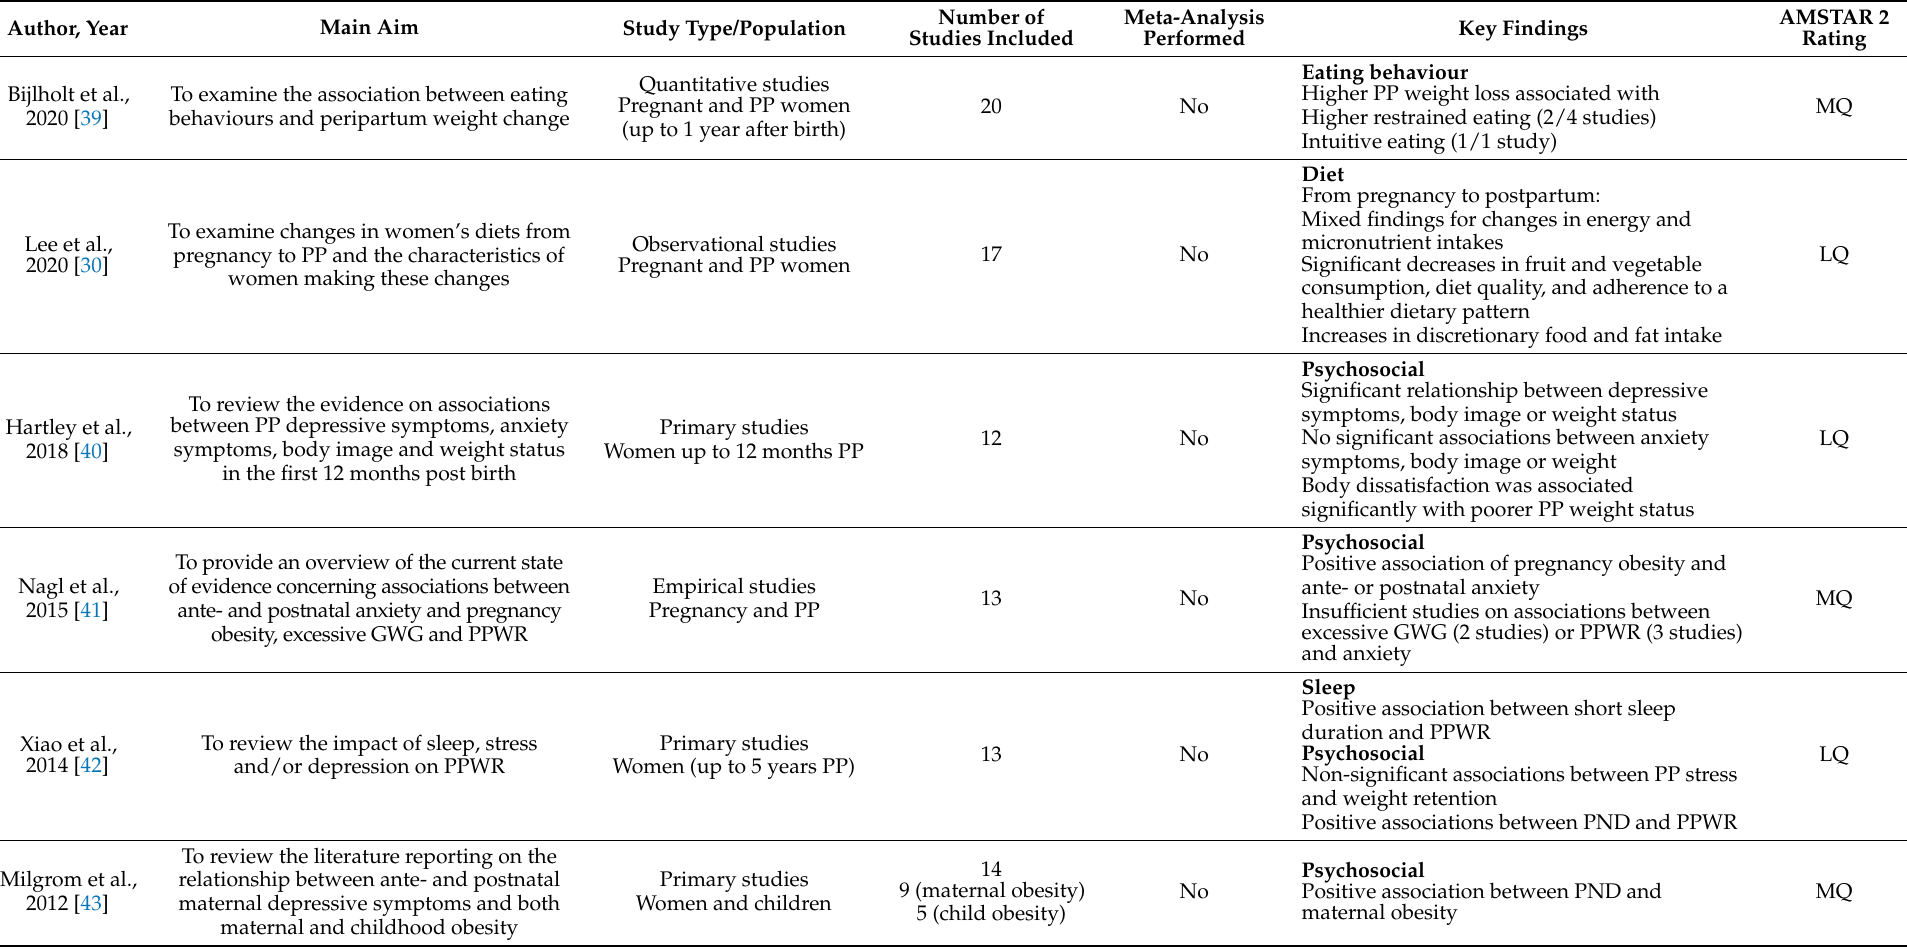
Table 1. Summary of systematic reviews examining the predictors of postpartum weight